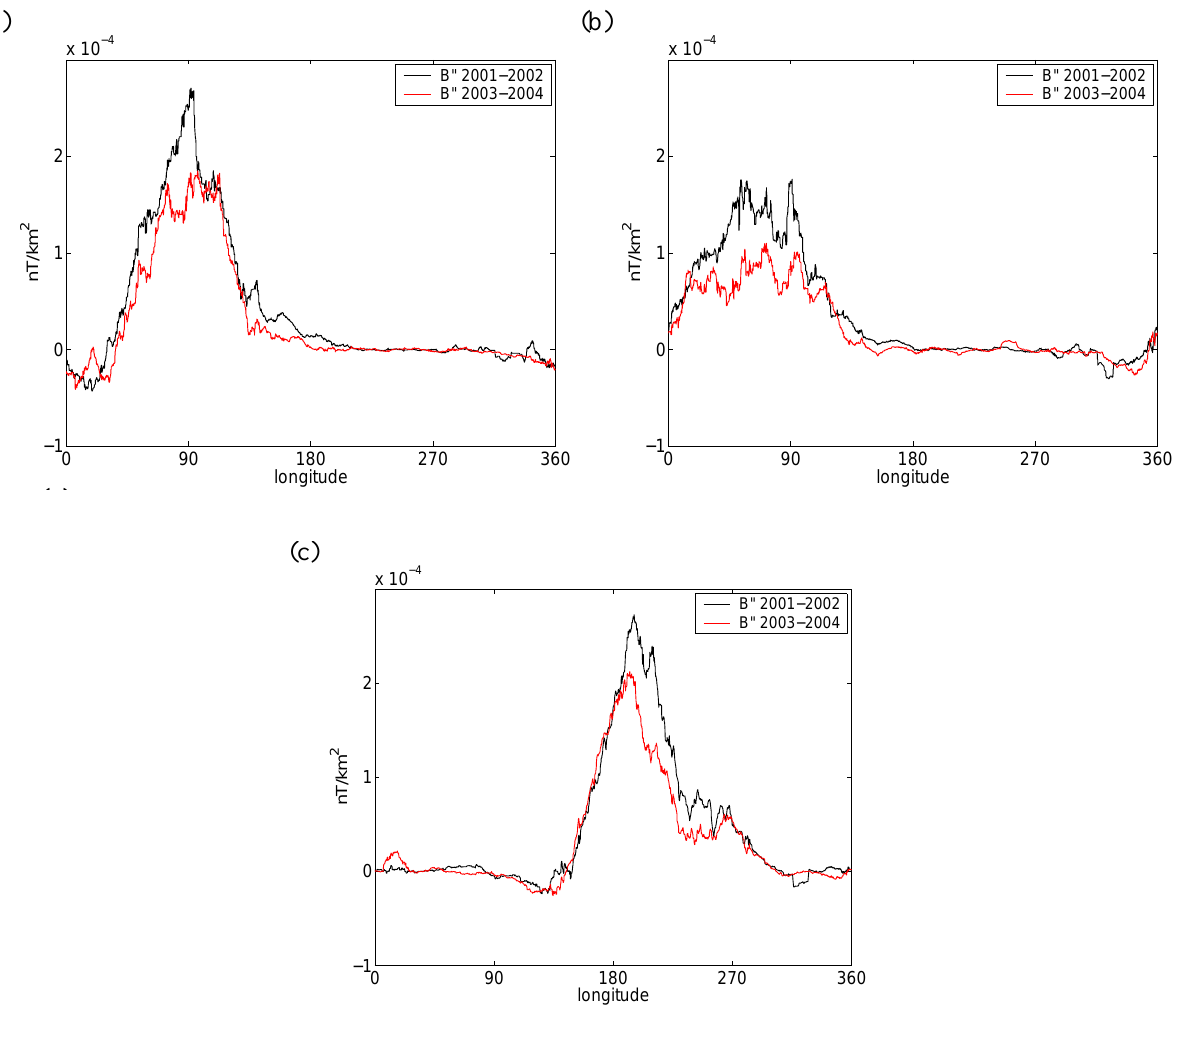
Fig. 11. Variation with universal time of the longitude profile of the equatorial electrojet field, longitudinal component, in nT/km 2 . The profiles are computed over 2001-2002 (black curves) and 2003-2004 (red curves) at 06:00 (a), 08:00 (b) and 22:00 (c). 1300 km has been chosen in order to average out the fluctua- tions associated with the satellite altitude